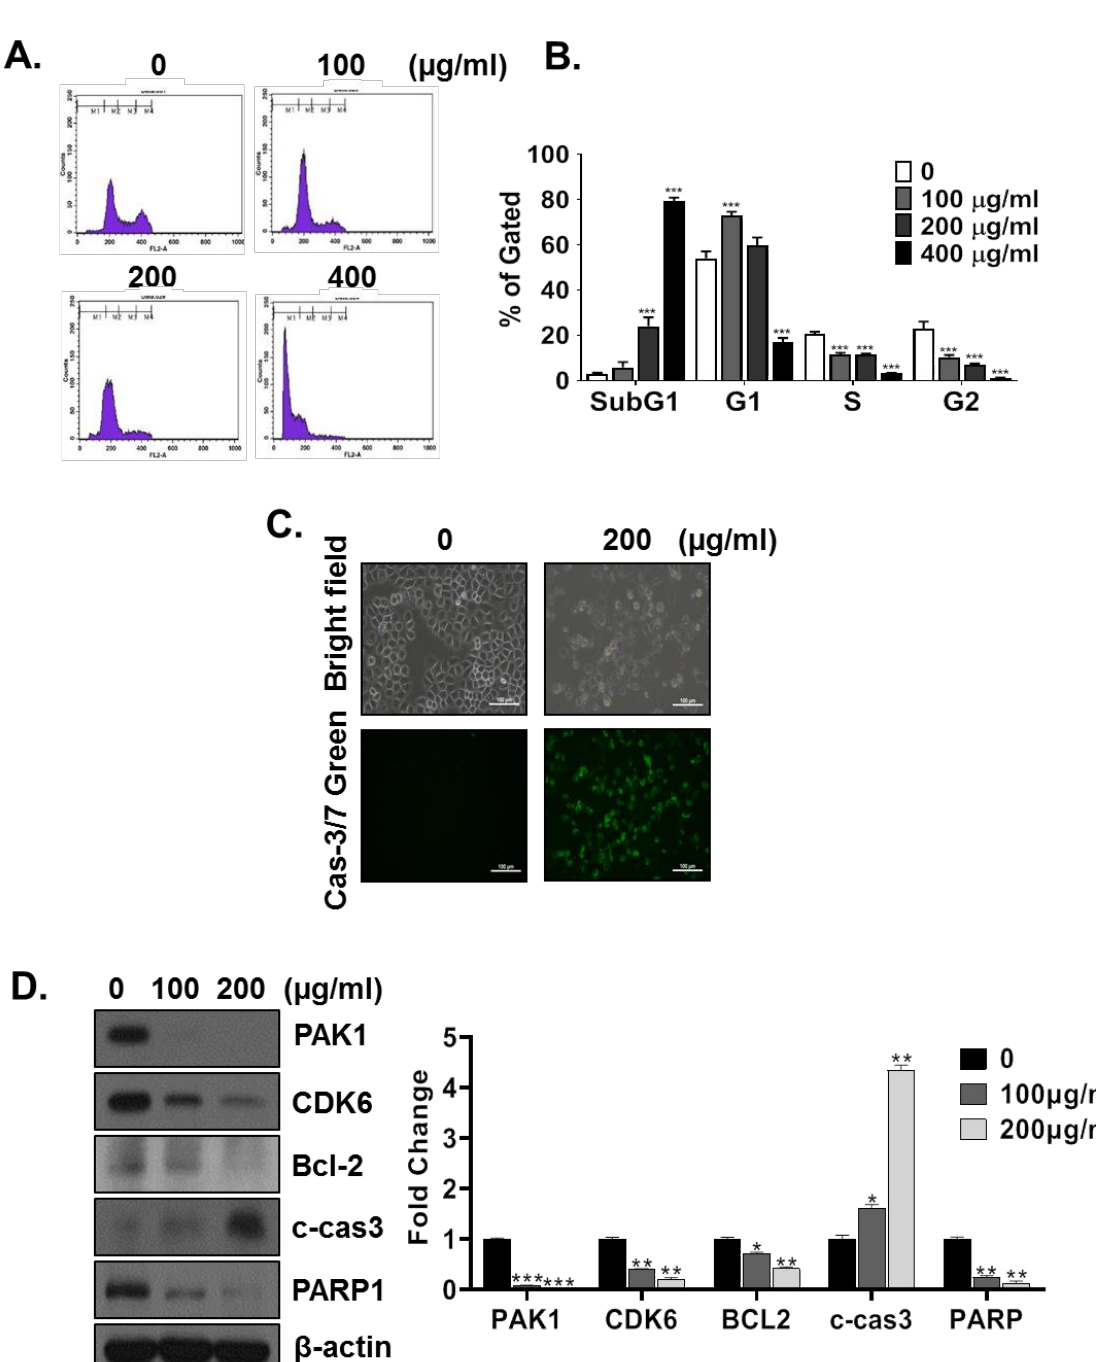
Figure 3. Effect of HMT on cell cycle arrest and apoptosis in PC-3 cells. PC-3 cells were treated with HMT (100, 200, and 400 μg/mL) for 24 h. ( A ) The treated cells were stained with propidium iodide (PI) and analyzed by flow cytometry. ( B ) Bar graphs show the quantification of the cell cycle population (%). Data represent mean ± SD. * p < 0.05, ** p < 0.01, and *** p < 0.001 compared with control. ( C ) PC-3 cells were treated with HMT (200 μg/mL) for 24 h and stained with 2 μM CellEvent for apoptosis analysis and imaged using a fluorescence microscope (200×) (Nikon, Tokyo, Japan). ( D ) HMT (100 and 200 µ g/mL)-treated PC-3 cell lysates were prepared and subjected to Western blotting for cell cycle- and apoptosis- related proteins (PAK-1, CDK6, BCL-2, cleaved caspase-3, PARP, and β -actin). Band density of proteins was quantified using the Gelpro analyzer (Media Cybernetic, Bethesda, MD, USA). The bar graph indicates the ratio of the protein of interest to β -actin by densitometric analysis presented as fold changes of the control. Data represent mean ± SD. * p < 0.05, ** p < 0.01, and *** p < 0.001 compared with